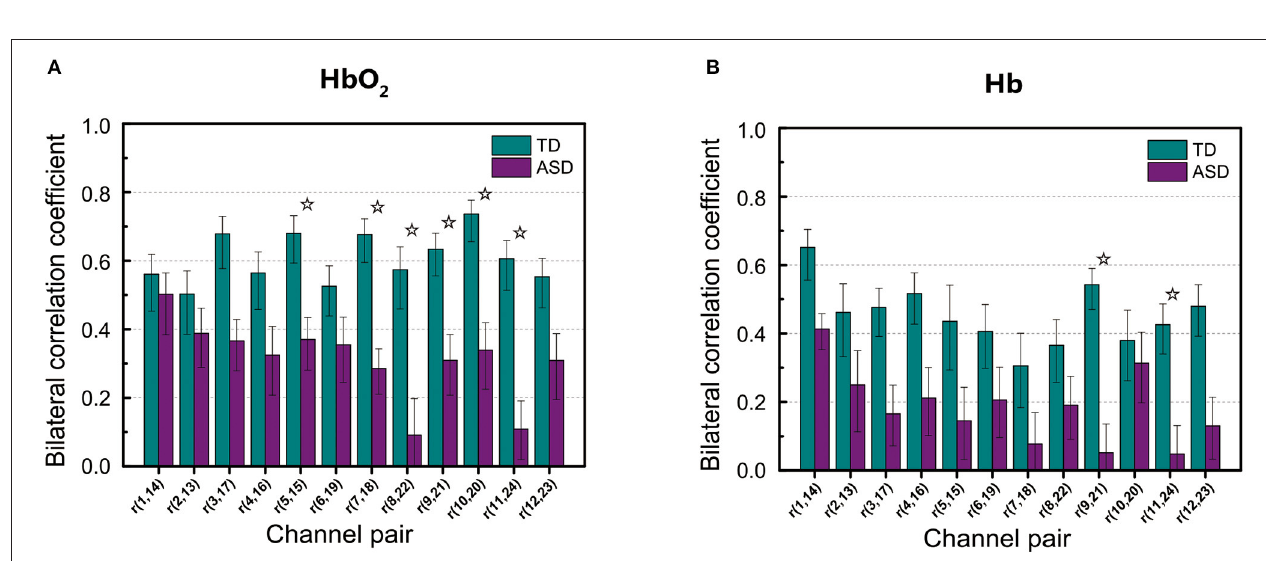
FIGURE 3 | The group average of correlation coefficients of HbO 2 (A) and Hb (B) in FB1 band for each mirrored channel pair located symmetrically on the left and right temporal lobes. The digit pair in the parenthesis indicates the corresponding channel pair, e.g., r (1,14) is the temporal correlation coefficient between channel 1 and channel 14. The asterisks indicate the differences in the correlation coefficient between ASD and TD are statistically significant (FDR-corrected q < 0.05) for the channel pair, and the statistical powers are larger than 0.8. The error bar for each correlation coefficient is the standard error of mean.